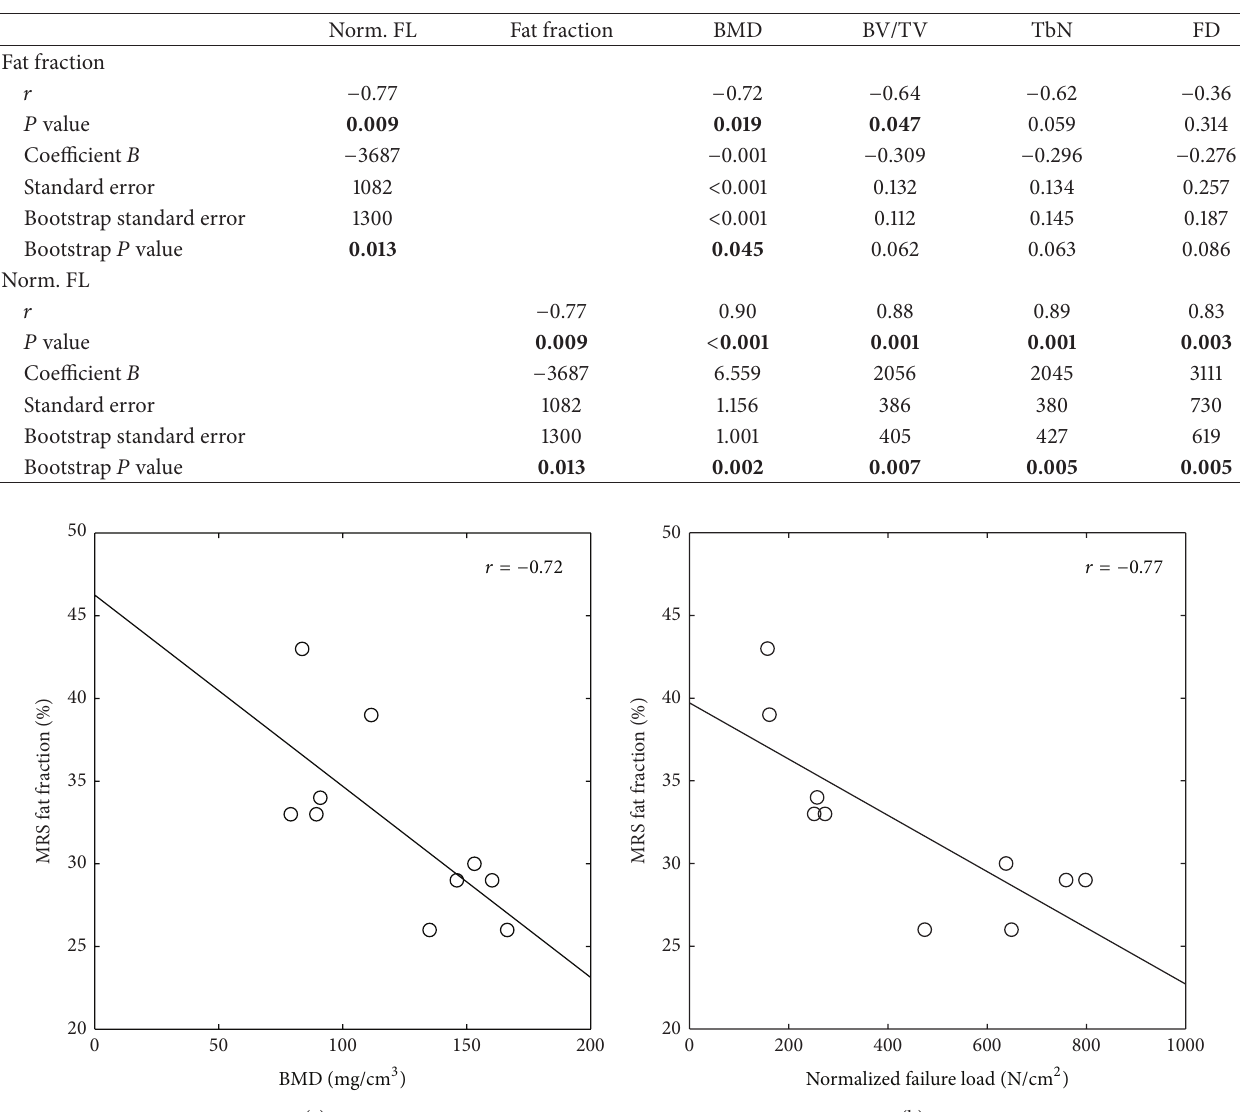
Table 2: Linear regression models with correlation coefficient 𝑟 , 𝑃 value, slope coefficient 𝐵 , and its standard error as well bootstrap derived standard error and 𝑃 value of (i) MRS-based proton density fat fraction with normalized failure load (norm. FL), BMD, and trabecular microstructure parameters and (ii) normalized failure load (norm. FL) with MRS-based proton density fat fraction, BMD, and trabecular microstructure parameters.